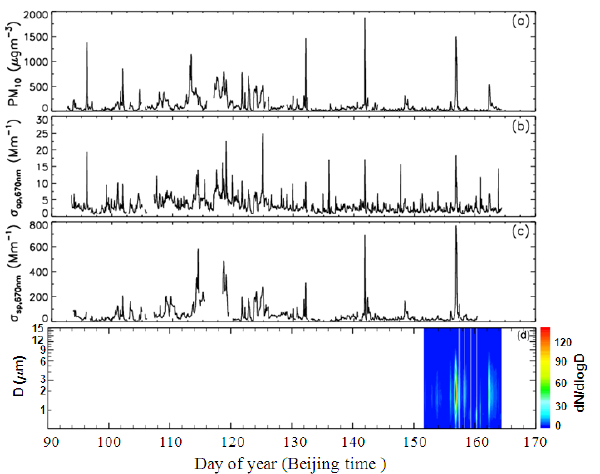
Figure 2. Time series of hourly-averaged (a) PM 10 mass concen- tration in µgm − 3 , (b) aerosol absorption coefficient at 670nm, (c) aerosol scattering coefficient at 670nm, and (d) aerosol size distri- bution in cm − 3 at the Dunhuang farmland during the whole sam- pling